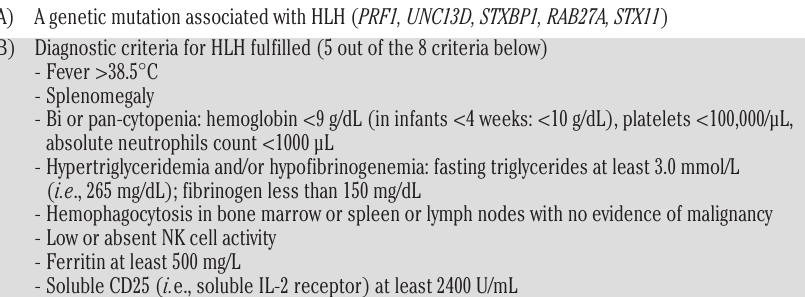
Table 1. Revised diagnostic guidelines for hemophagocytic lymphohistiocytosis (HLH) used in the HLH-2004 trial. 9 The diagnosis of HLH can be made if either A) or B) below is